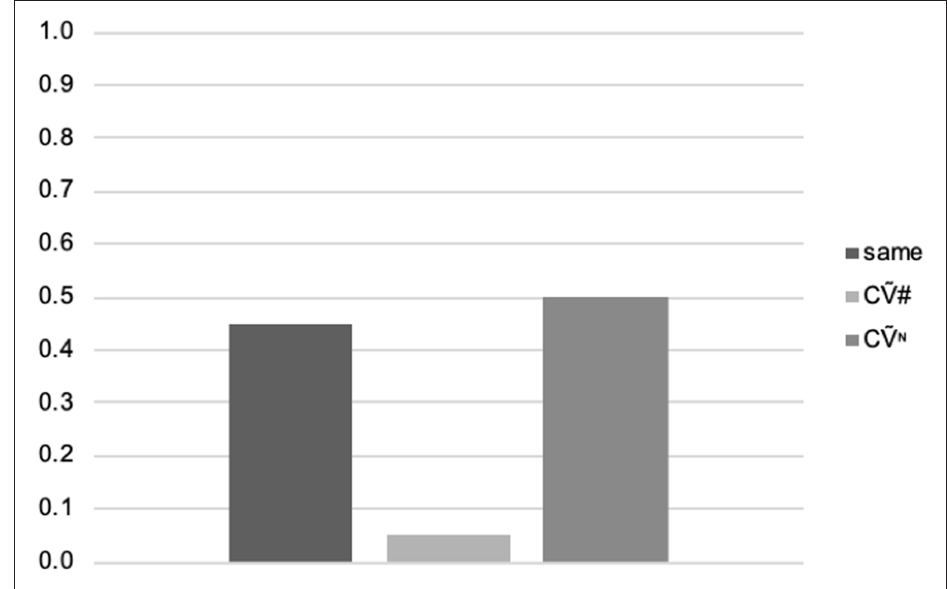
Figure 4: Rating responses for stimulus pairs type